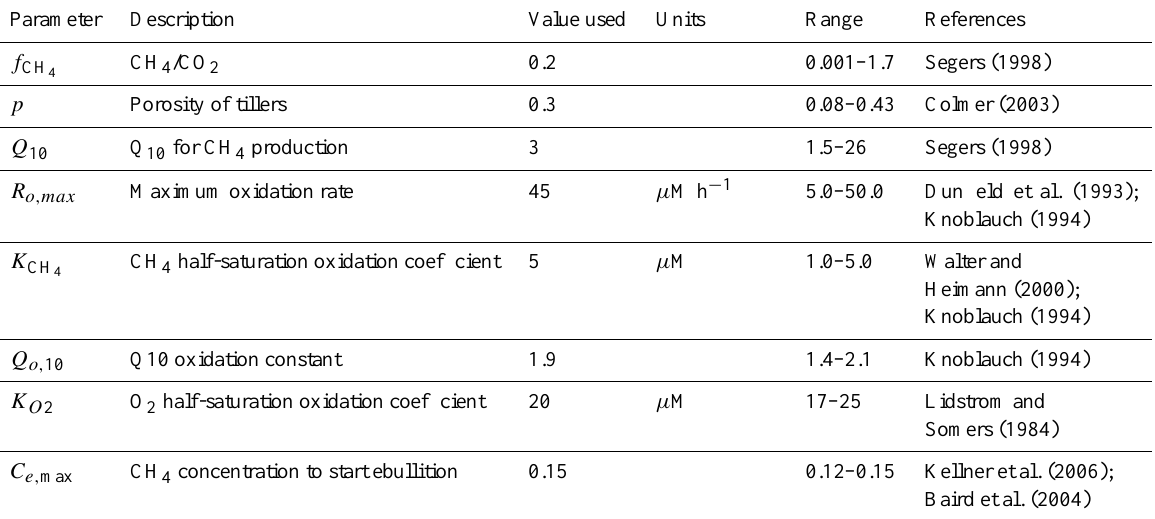
Table 4. Parameters used for sensitivity